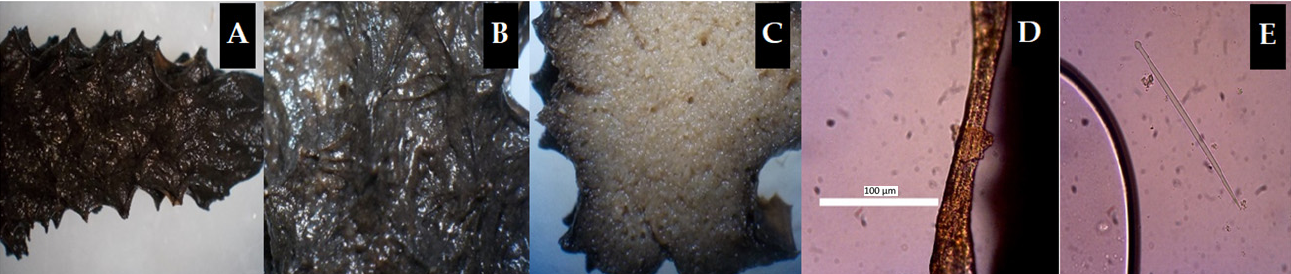
Figure 1. The morphology of marine sponge Niphates sp. (Sp1): ( A ) consistency; ( B ) surface; ( C ) skeleton; ( D ) skeletal tract; ( E ) spicules (40 × ).